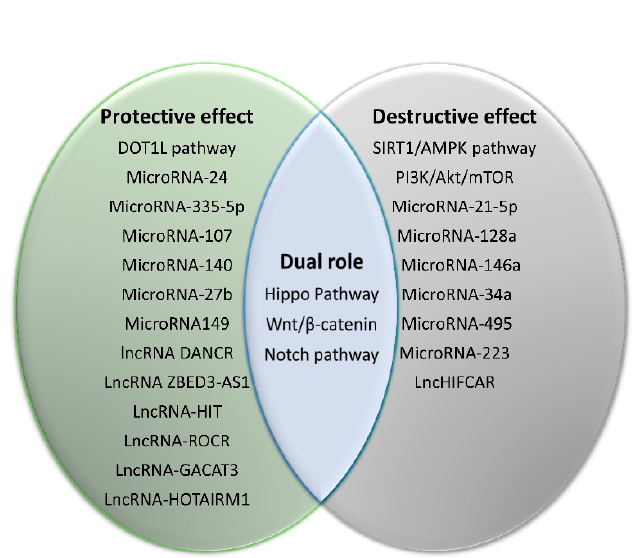
Figure 2. Regulatory factors and pathways involved in OA pathogenesis.